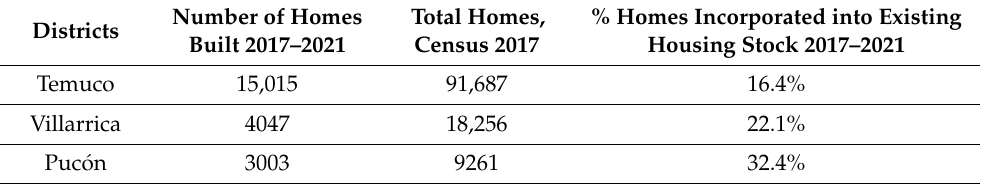
Table 3. Districts with the greatest number of homes built in the period 2017–2021, Araucan í a Region.